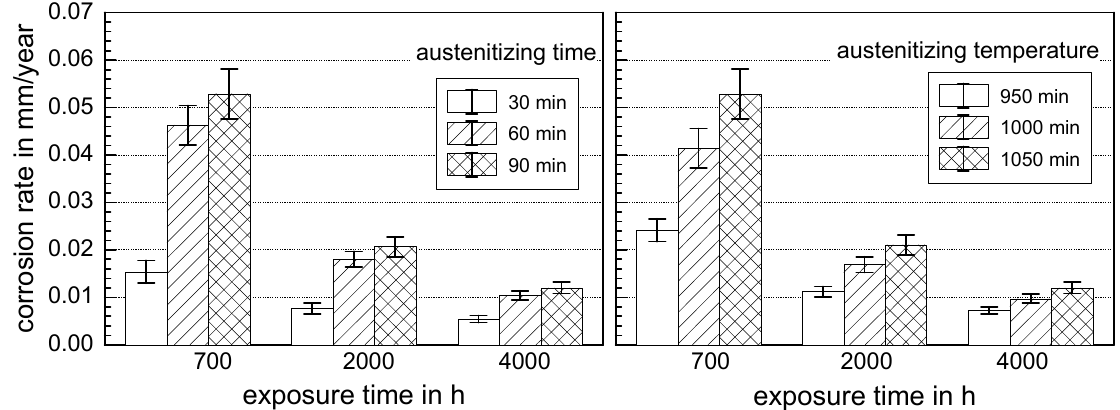
Figure 9. Influence of austenitizing: Surface corrosion rate (combined: X20Cr13 and X46Cr13 annealed at 650 ◦ C for 30 min) as a function of austenitizing time and temperature prior to exposure to CO 2 -saturated saline aquifer water.